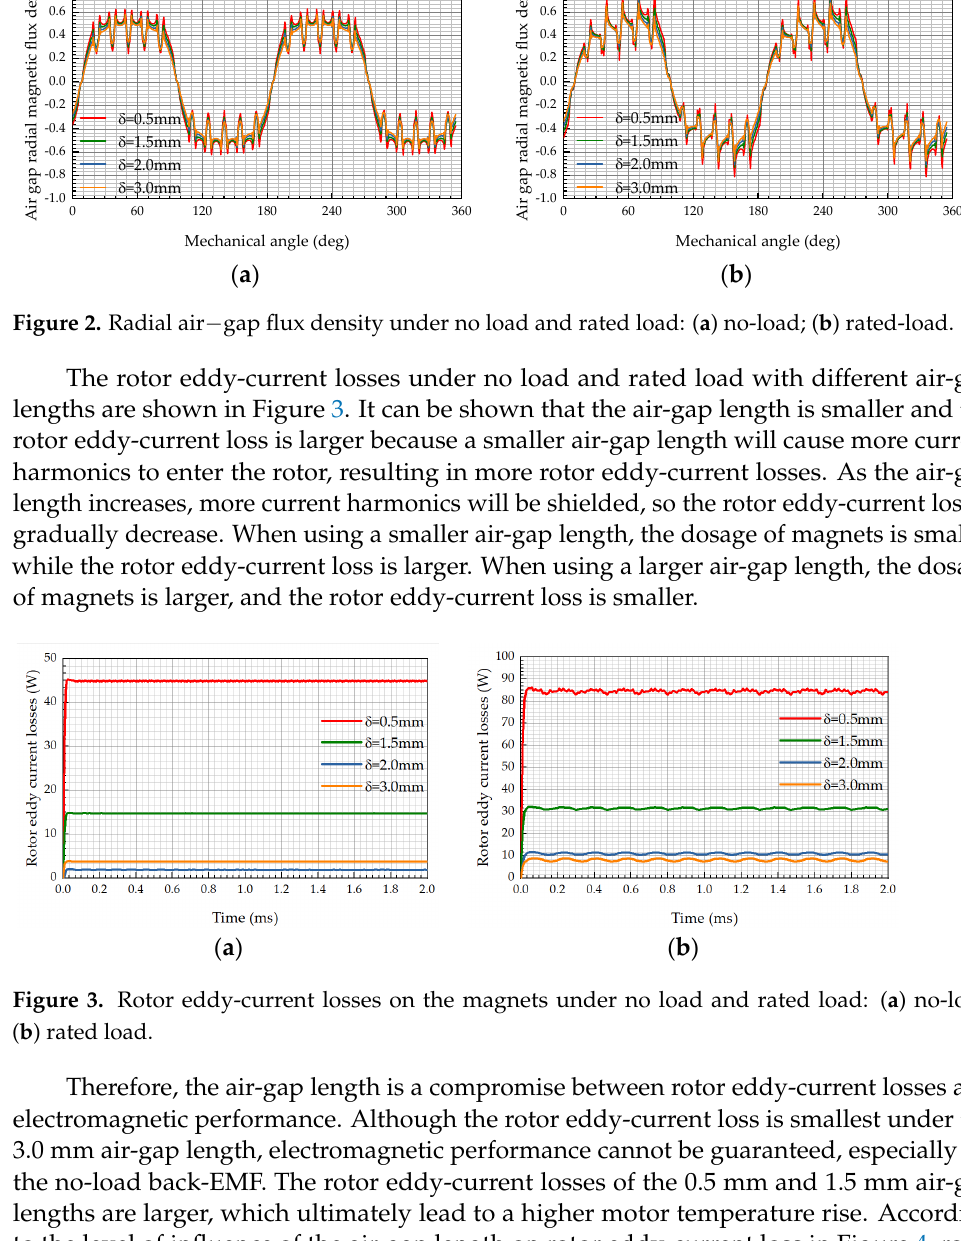
Figure 3. Rotor eddy ‐ current losses on the magnets under no load and rated load: ( a ) no ‐ load; ( b ) rated load.